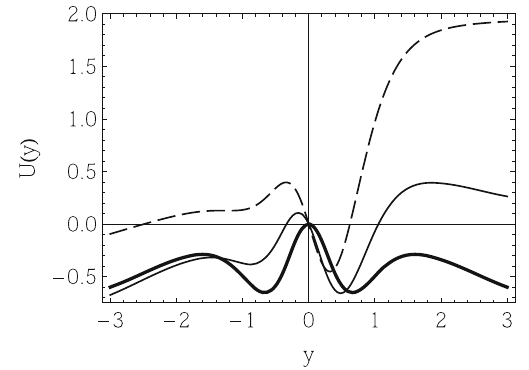
Fig. 20 Plot of U ( y ) for U ( 0 ) = 0, ψ 0 = 1, and ϕ 0 = 1 . 45, with c = 0 (thick solid line), c = 1 (thin solid line), and c = 0 . 4 (dashed